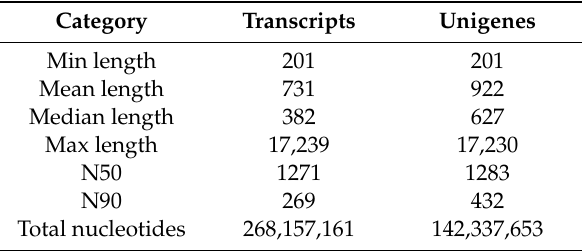
Table 2. Summary of generated transcripts and